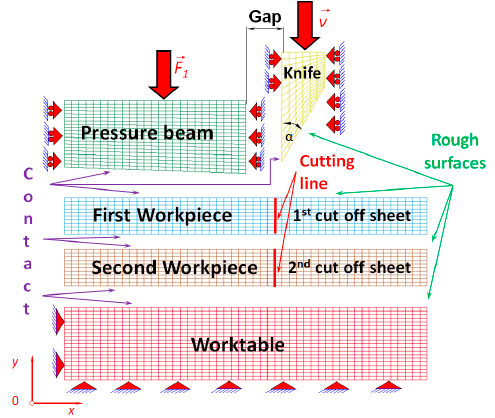
Figure 3. Mesh of the physical model of a bundle being cut.